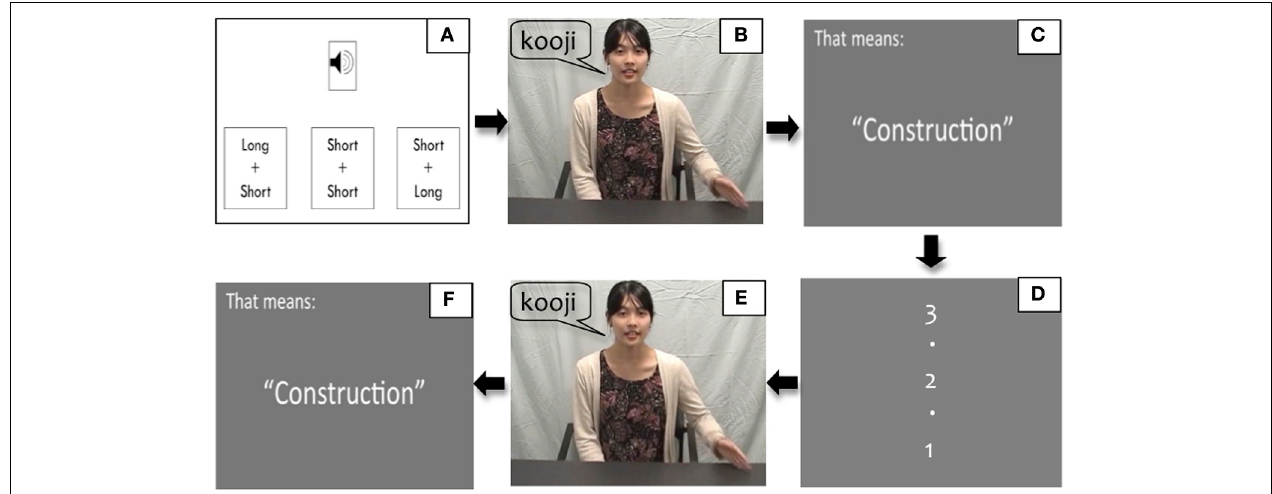
FIGURE 2 | Training steps. (A) Listen to the target word audio, e.g., [ko : ji], and click one of the three alternatives, e.g., “Long + Short”; (B) Watch the instructor speaking the target word, e.g., [ko : ji], and showing syllable or mora gestures along with speech; (C) See the